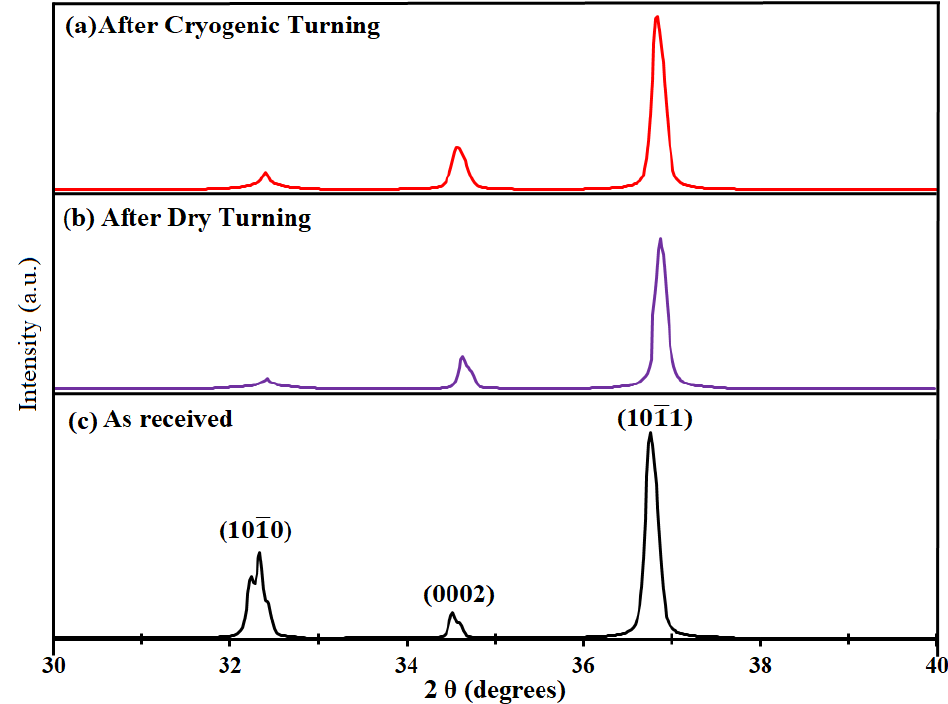
Figure 8. XRD patterns of the AZ31C magnesium alloy samples.